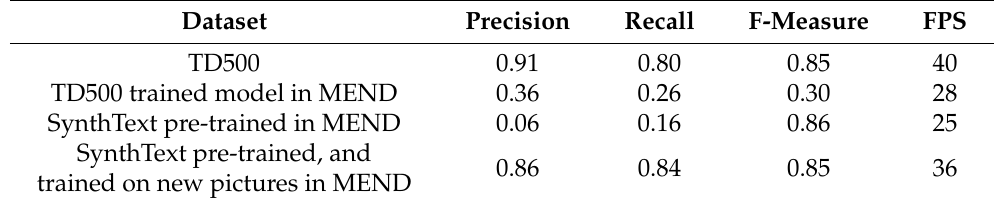
Table 4. Comparison test: DBNet takes ResNet50 as the backbone. Using a deeper neural network as the backbone ResNet50 with slightly reduced prediction speed still achieved significantly better performance than ResNet18.